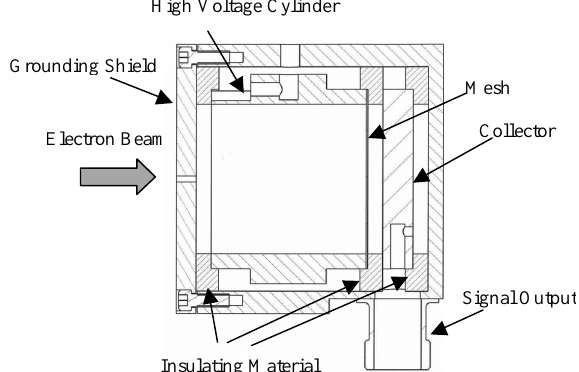
FIG. 1. Schematic of the energy analyzer with cylindrical high voltage electrode. The length is 4.3 cm and the diameter is 5.1 cm. The aperture diameter is 1 mm.